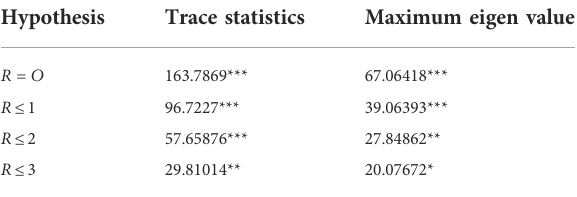
TABLE 7 Johansen cointegration results.